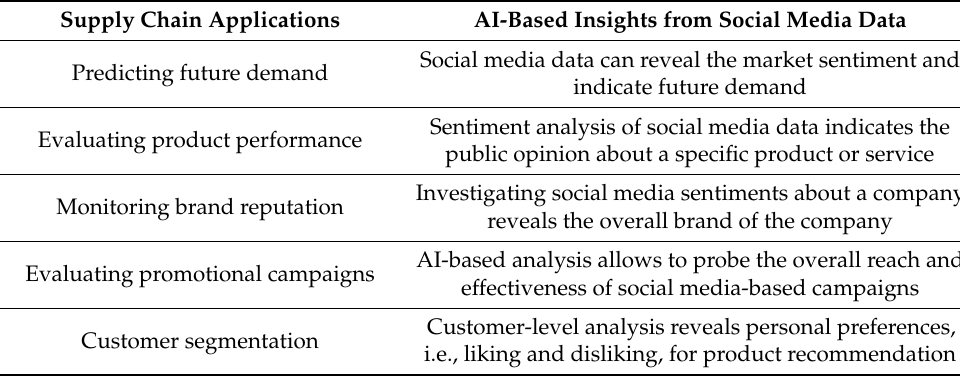
Table 2. Scope of Sentiment analysis for